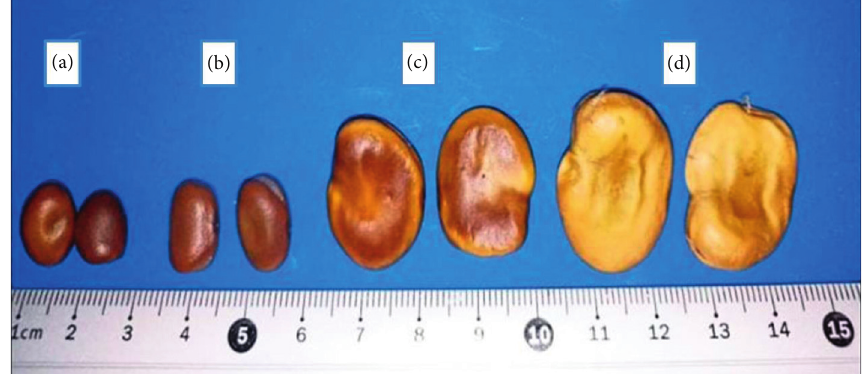
Figure 3: a, b) shortest seeds of the studied accessions of Vicia faba L. (“202 lot2” and “01-02”); (c, d) longest seeds of the studied accessions of Vicia faba L. (“Memdouh” and